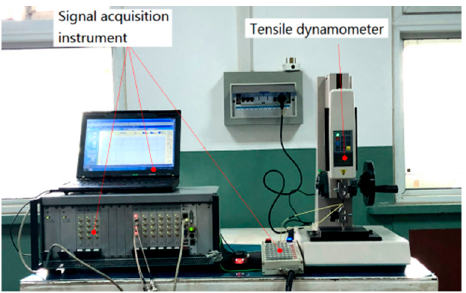
Figure 4. Thin-film resistance grid tensile test diagram.